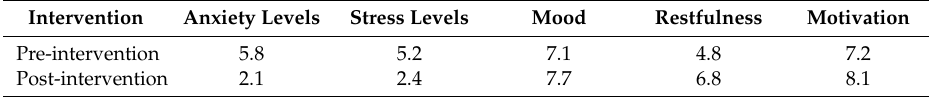
Table 2. The mean scores for anxiety and stress levels, mood, restfulness and motivation before and after the music therapy self-care group.